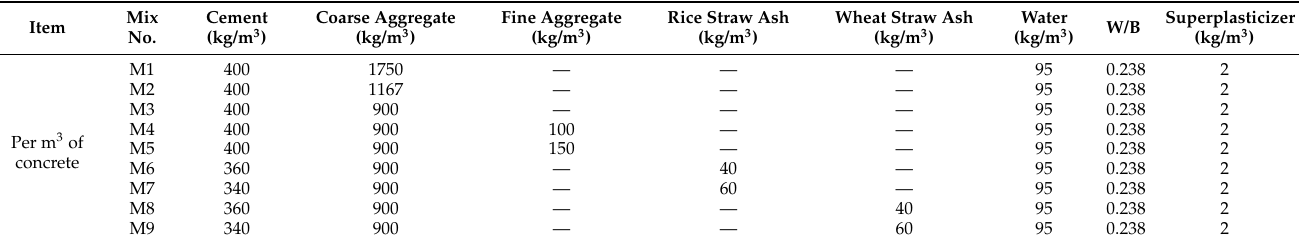
Figure 1. Experimental program for Phase I. Table 1. Concrete mix design for Phase